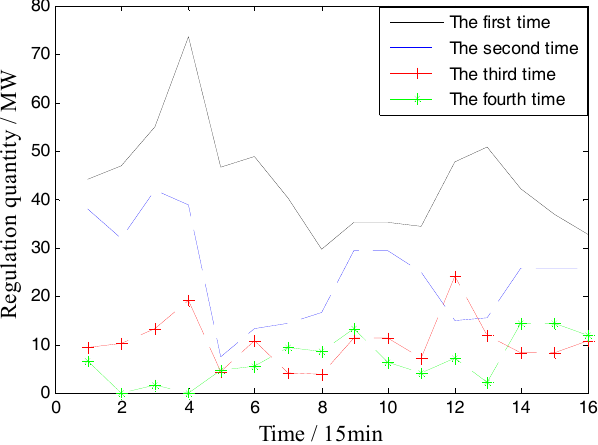
Figure 13. The output regulations for each period (Case 7).